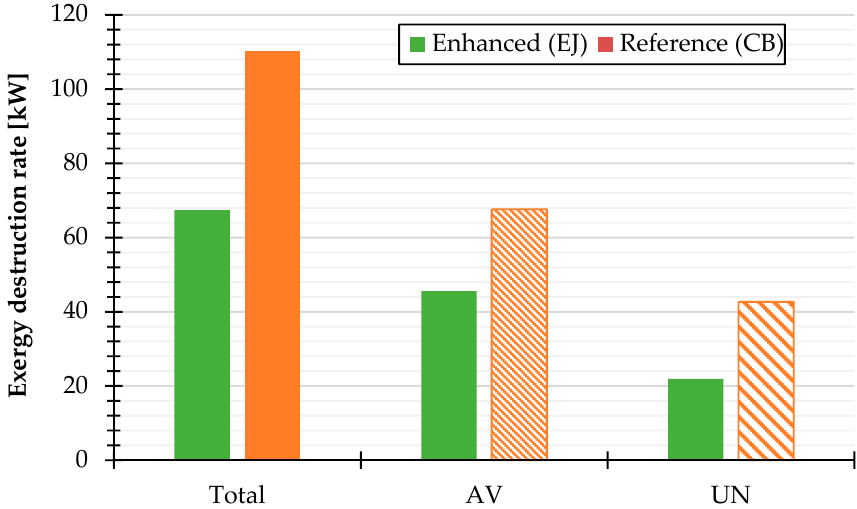
Figure 7. Comparison of the exergy destruction rates associated with the reference (CB) and enhanced (EJ) systems at the outdoor temperature of 40 °C. Energies 2018 , 11 , x FOR PEER REVIEW